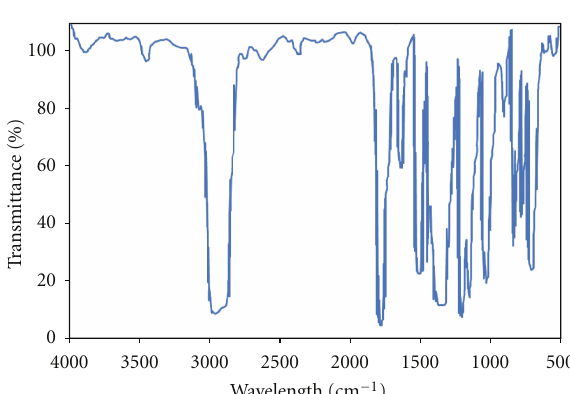
Figure 8: FTIR spectrum of reference sample after treating 45 days with UV